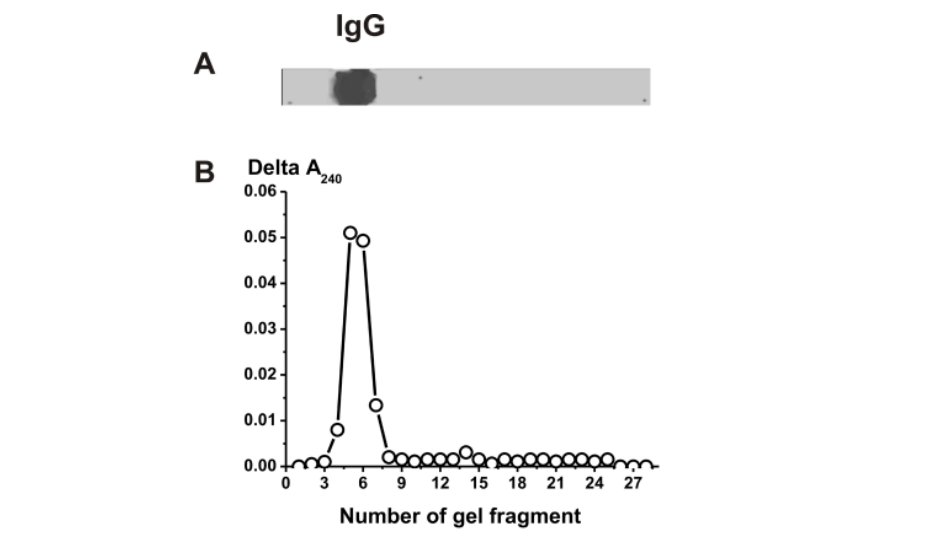
neous development of EAE.